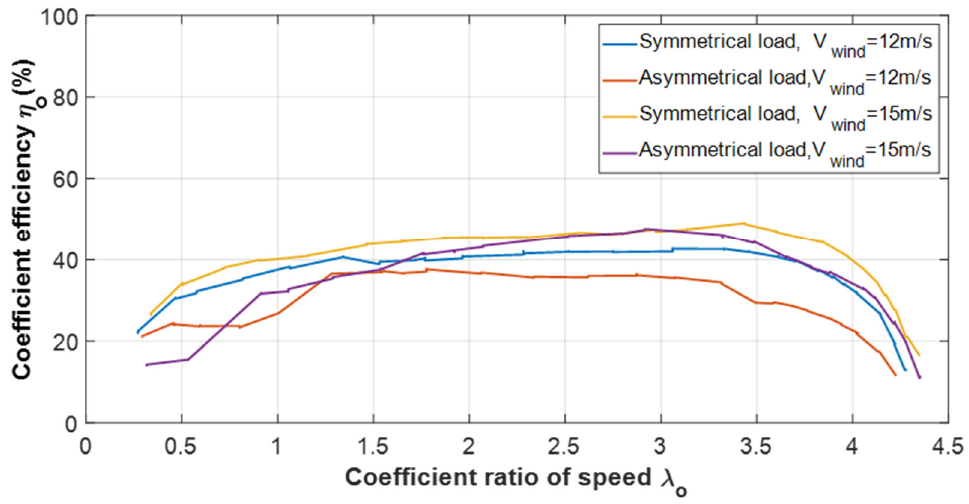
Figure 28. Comparison of the symmetrical and asymmetrical load of a three-phase generator.